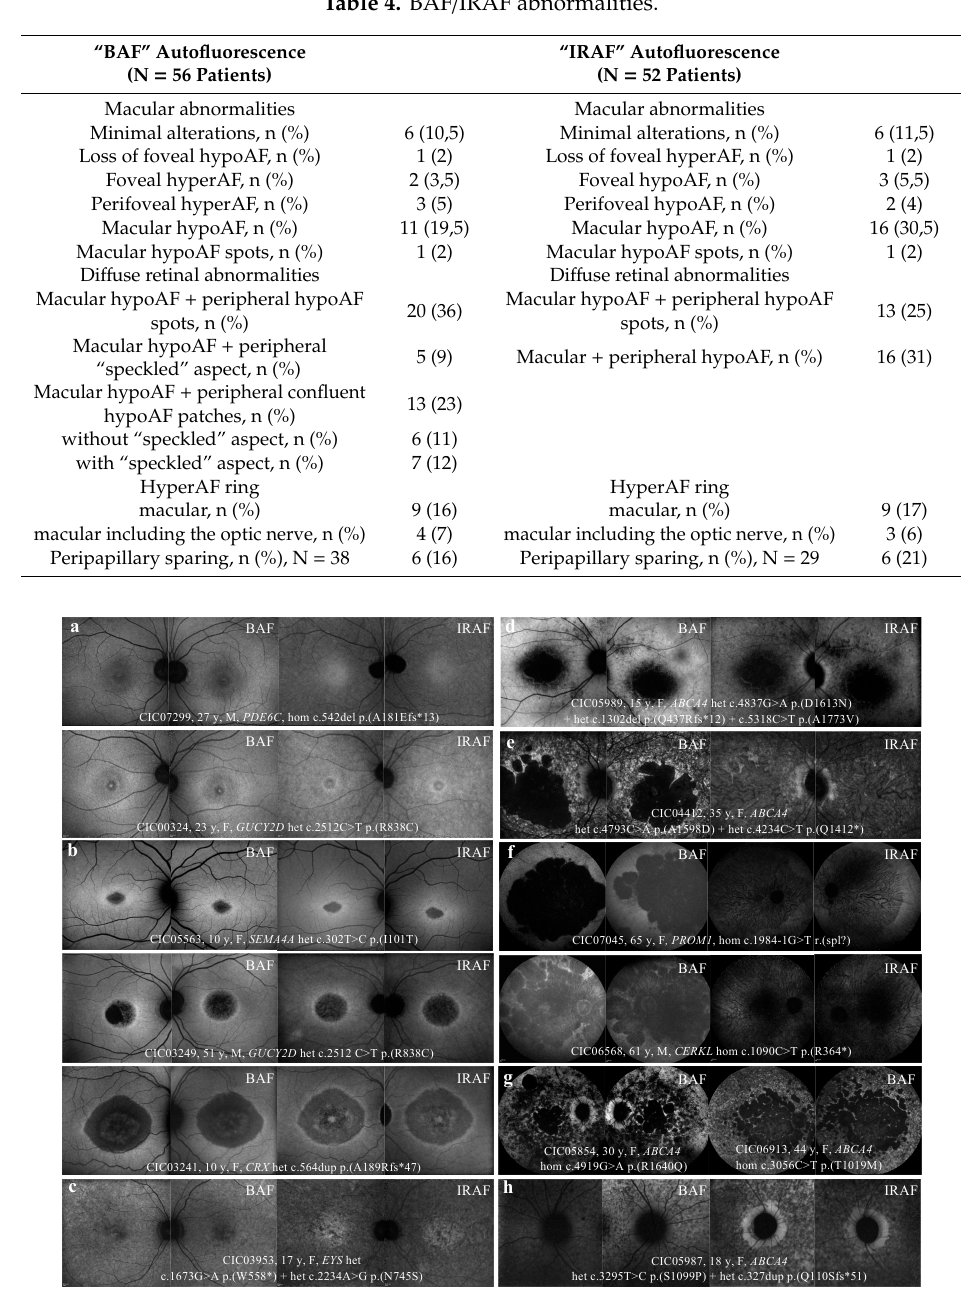
Figure 3. FAF and IRAF patterns observed in COD / CORD patients of the cohort. ( a ) Foveal and perifoveal hyperAF in BAF; foveal and perifoveal hypoAF in IRAF. ( b ) Macular hypoAF surrounded by a hyperAF ring in BAF and IRAF. ( c ) Macular hypoAF spots in BAF and IRAF. ( d ) Macular hypoAF associated with peripheral hypoAF spots in BAF and IRAF. ( e ) Macular hypoAF associated with peripheral “speckled” aspect (alternating hypoAF and hyperAF spots) in BAF and confluent hypoAF spots in IRAF. ( f ) Confluent hypoAF areas, involving the optic disc and extending beyond the vascular arcades. ( g ) Extensive and confluent hypoAF areas with a “speckled” aspect, associated ( left ) or not ( right ) with peripapillary sparing. ( h ) Sparing of peripapillary autofluorescence, more pronounced in IRAF than in BAF in this case. HypoAF: hypo-autofluorescence / hypo-autofluorescent; HyperAF: hyper-autofluorescence / hyper-autofluorescent; BAF: blue autofluorescence; IRAF: infrared